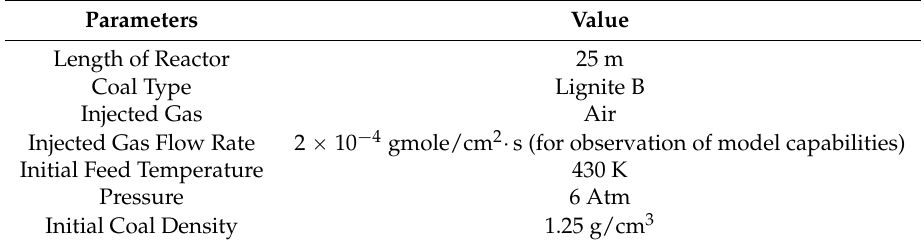
Table 9. Input parameters for UCG packed bed model developed by Uppal et al. [43].